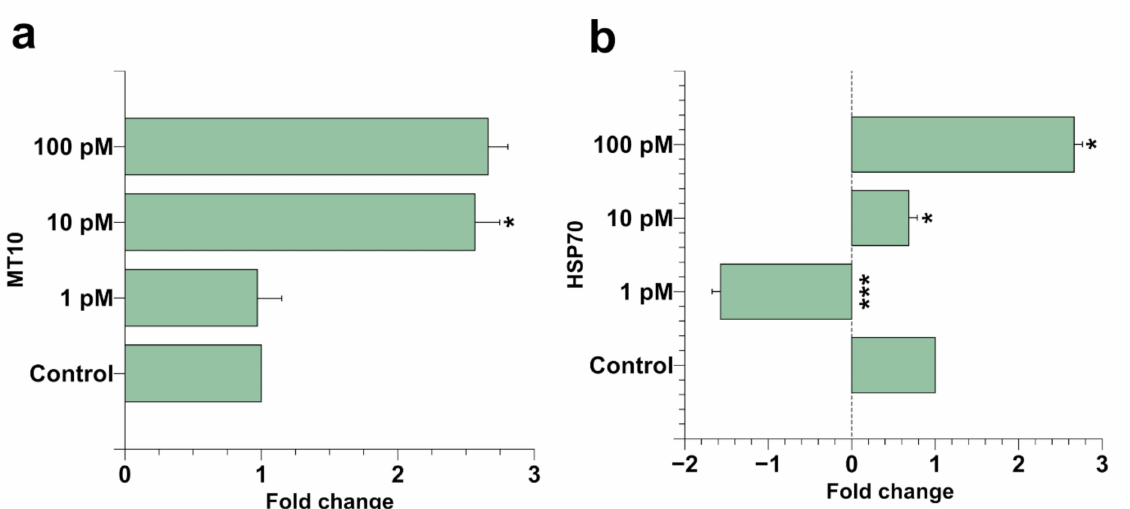
Figure 2. RT-qPCR expression analysis of M. galloprovincialis spermatozoa mt10 and hsp70 . In the figure, the fold change of the expression of the transcripts of mt10 ( a ) and hsp70 ( b ) is reported in the three HgCl 2 exposure conditions with respect to the control condition (unexposed mussels), after determining their relative expression in comparison to the reference housekeeping 18S gene. Mussels were unexposed and exposed to 1, 10, and 100 pM HgCl 2 . Values are presented as mean ± S.D. ( n = 6); asterisks indicate a statistically significant difference compared to unexposed mussels: * = p < 0.05; *** = p <